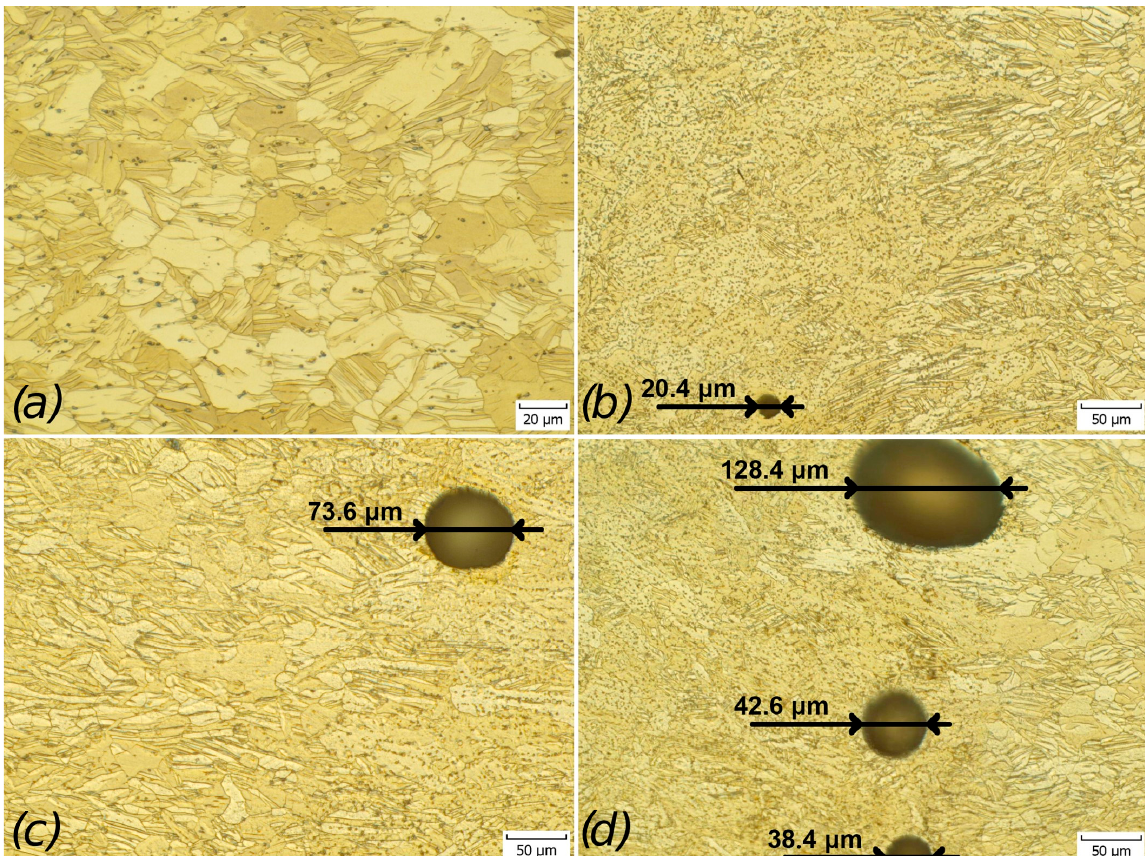
Figure 5. Microstructure of ( a ) BM, ( b ) WM–HAZ interface of weld joint no. 1, ( c ) BM–HAZ–WM interface of weld joint no. 2, ( d ) WM–HAZ–BM interface of weld joint no. 3.